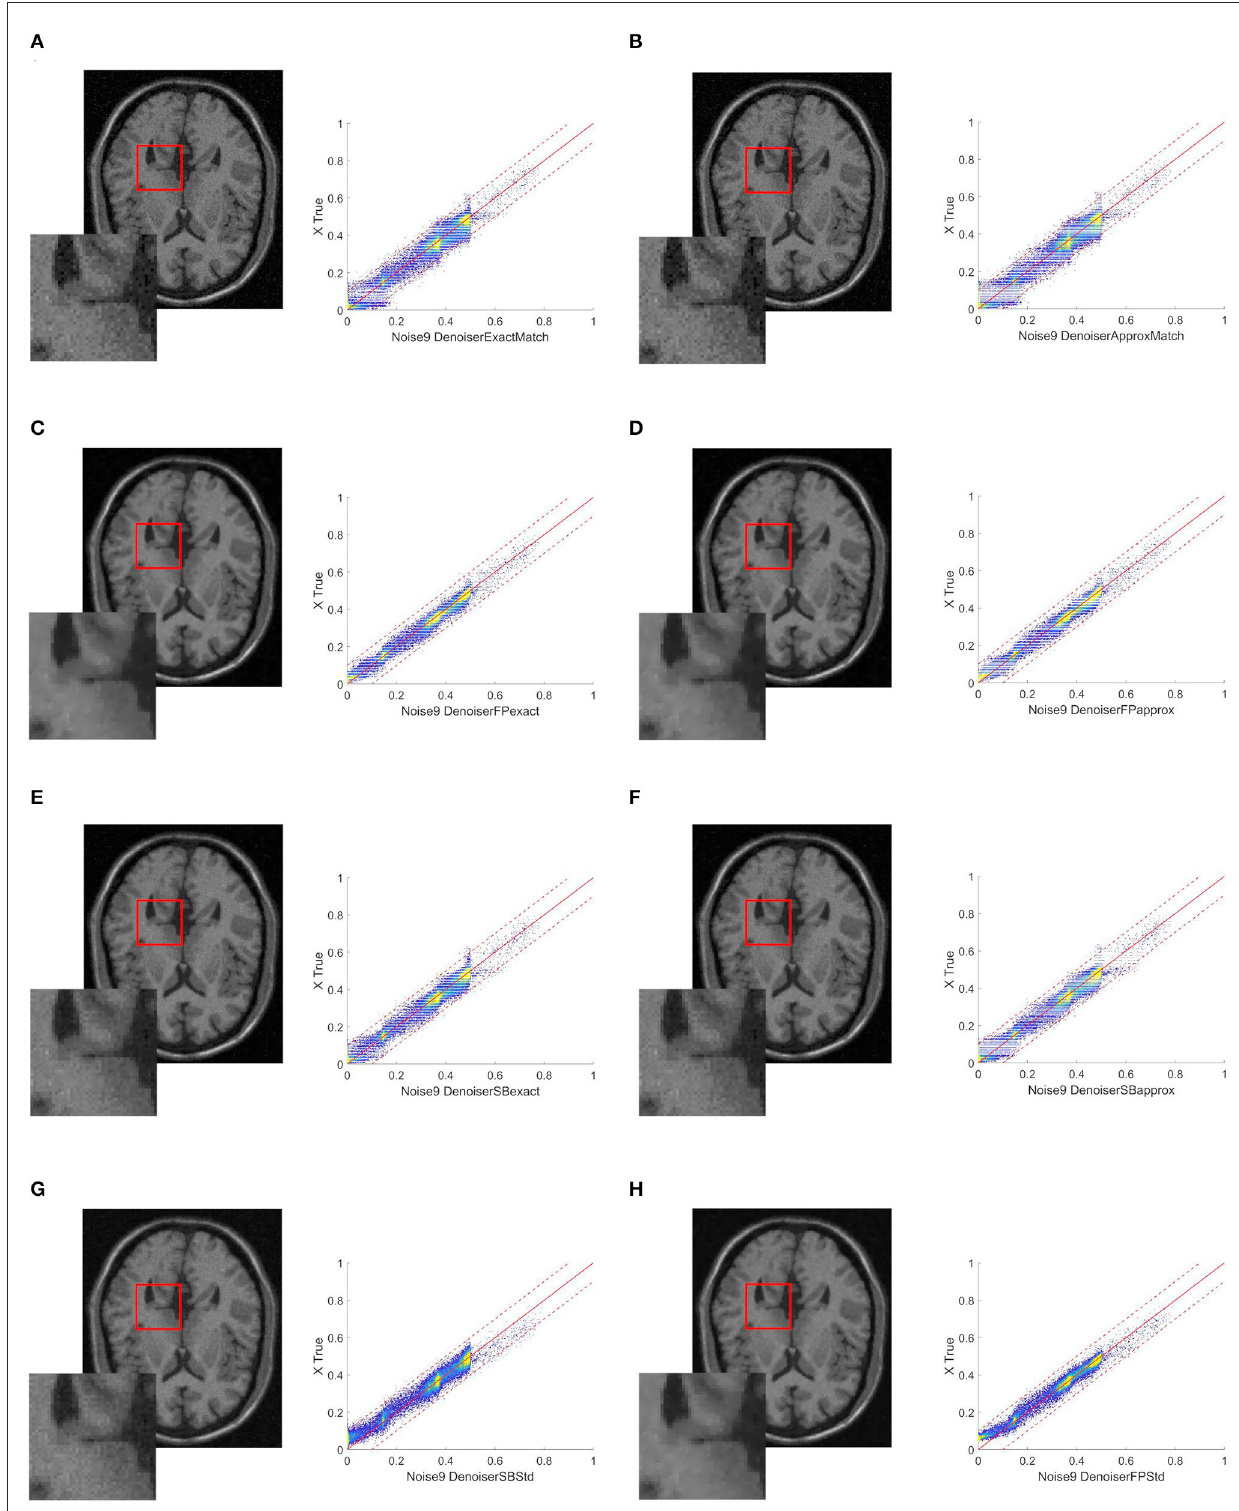
FIGURE1 Simple proof of concept outcomes. When the matching procedure is carried out with the original image as the target, the following images are produced. (A) ExactMatch and (B) ApproxMatch applied to the image with 9 % noise. (C) FP exact and (D) FP approx denoiser applied to the image with 9 % noise. (E) SB exact and (F) SB approx applied to the image with 9 % noise. (G) SB standard and (H) FP standard applied to the image with 9 %